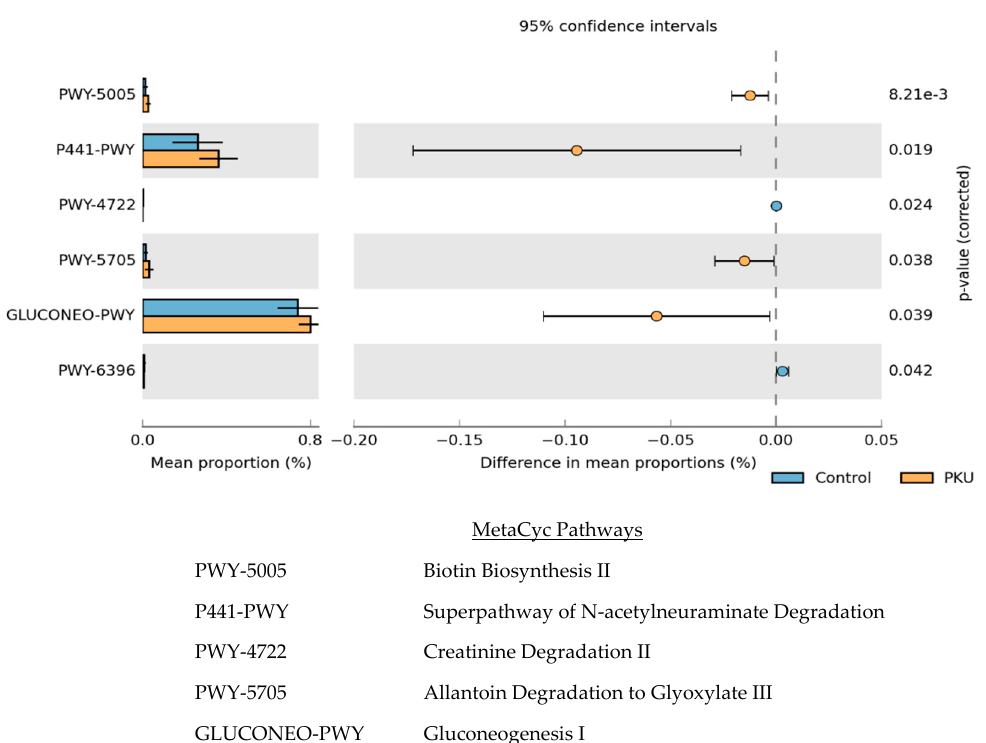
Figure 6. The relative abundance of predicted microbial genes related to metabolism in control (blue) and PKU (orange)